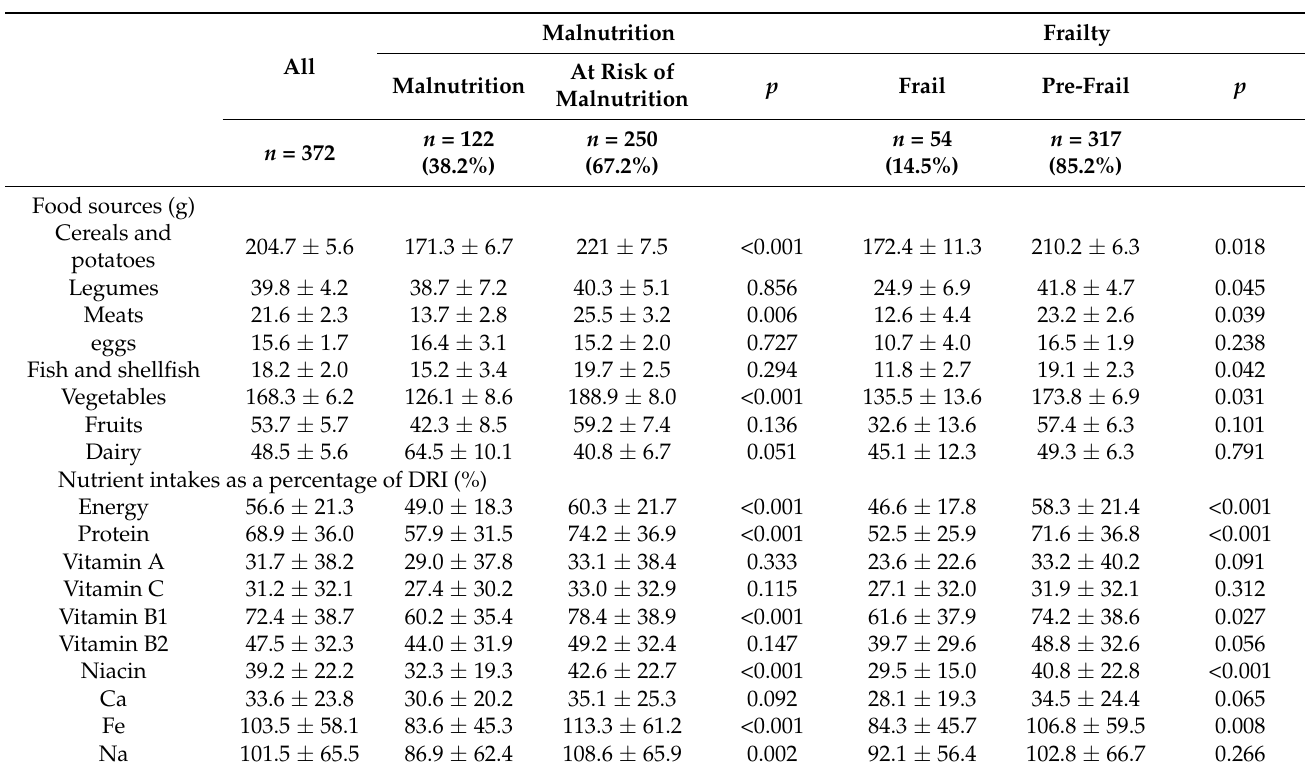
Table 2. Food sources and nutrient intake according to malnutrition and